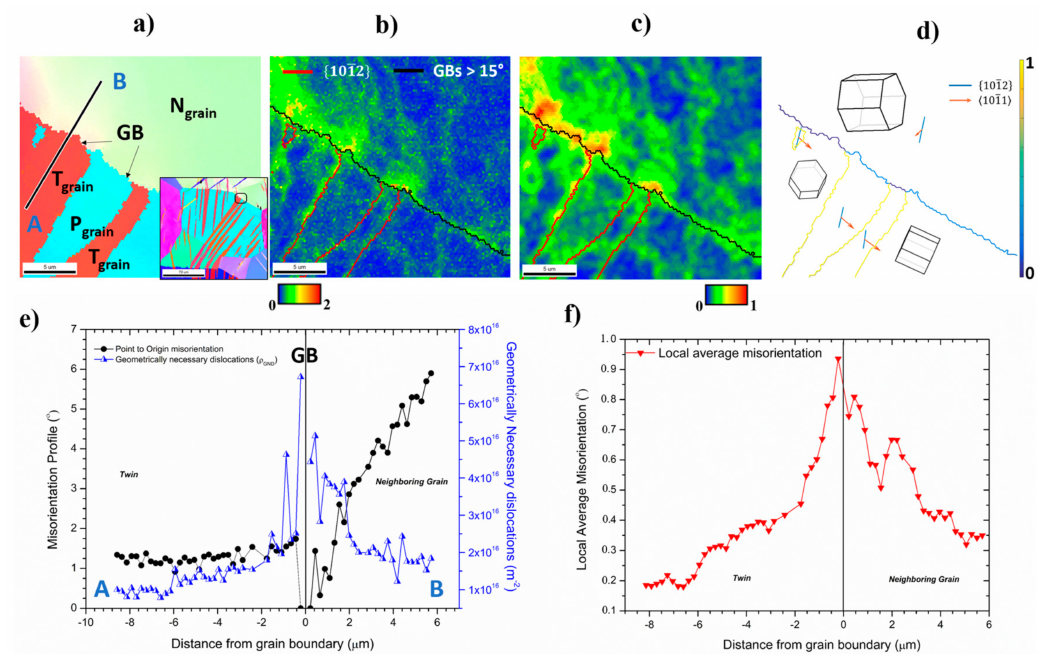
Figure 7. ( a ) Inverse pole figure (IPF) map of twin lamellae intersecting a grain boundary; inset image shows a low magnification IPF map enclosing the area of interest highlighted in black square. Slit orientation between points A and B is shown schematically; parent, twin and neighbor grains are labelled as P grain , T grain and N grain ; ( b ) KAM, ( c ) LAM and ( d ) m (cid:48) maps corresponding to twin (cid:8) (cid:9)(cid:10) (cid:11) transmission across grain boundary ( 1012 1011 tension twin boundaries shown in red and high angle grain boundaries shown in black); ( e ) GND density and misorientation profile (with respect to the grain boundary) inside twin and neighbor grain and ( f ) LAM profile between points A and